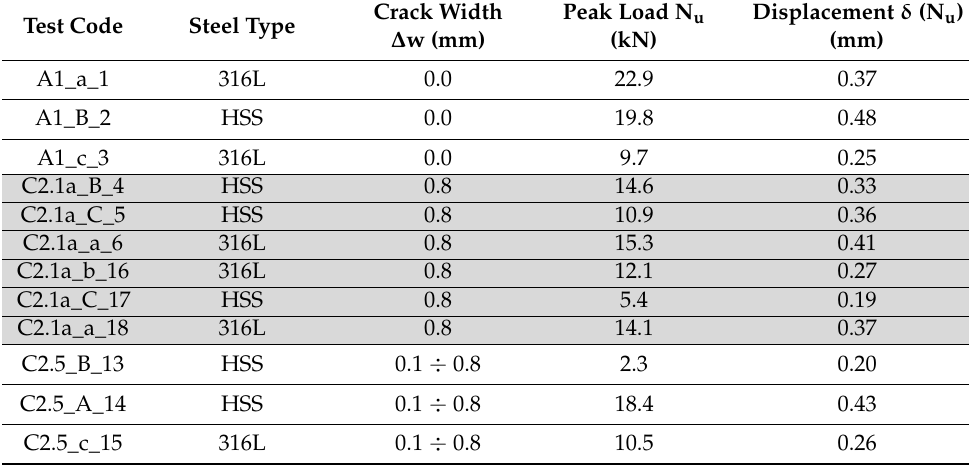
Table 4. Test results of tensile